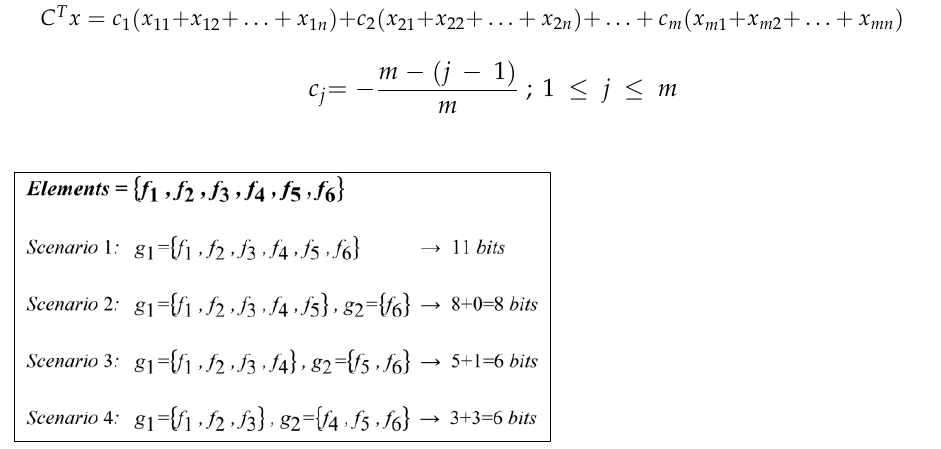
Figure 4. Different scenarios for generating key from a group of six elements using PSC.